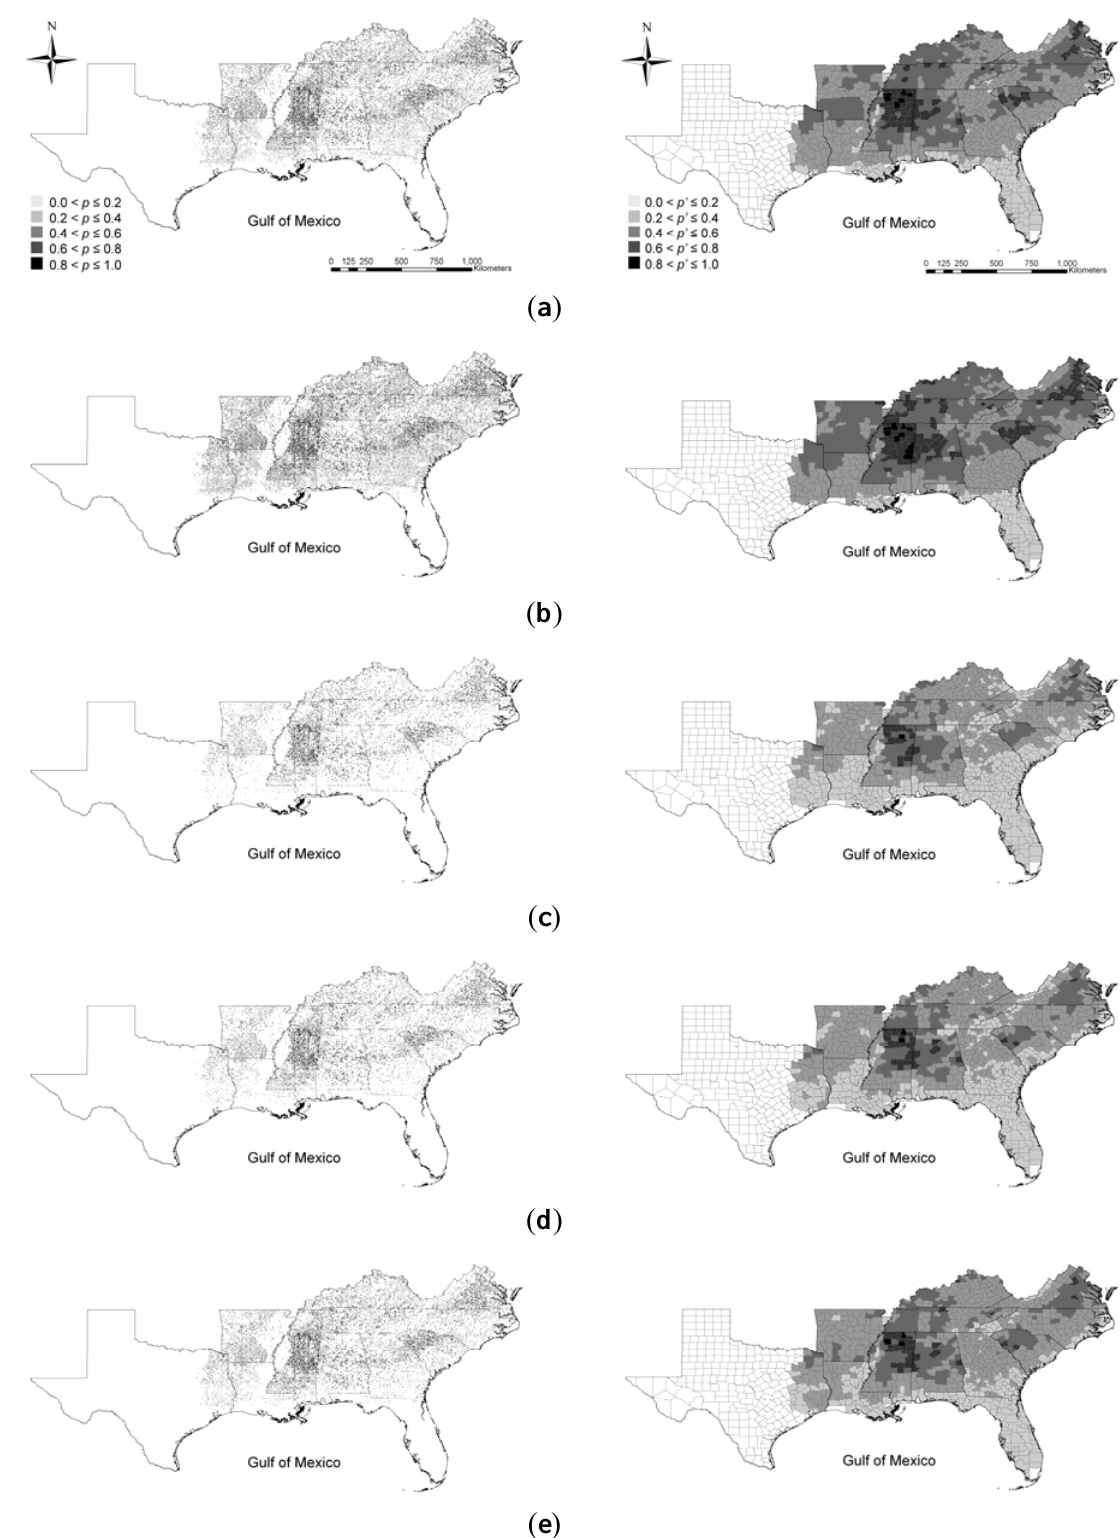
Figure 2. Estimated probability of occupancy of forestlands in each U.S. Forest Service plot (left) and average estimated probability in each county (right) in the southern United States by L. japonica with ( a ) no management; ( b ) global climate change; ( c ) public ownership; ( d ) artificial regeneration; and ( e ) fire